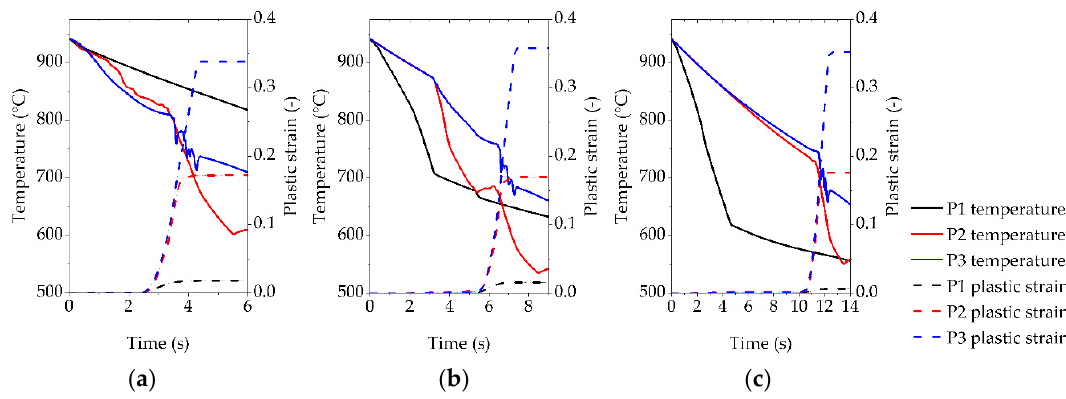
Figure 16. Temperature–plastic strain vs. time diagram for the X46Cr13 alloy during blank transfer and forming step from an initial austenitization temperature of 1050 °C for different soaking time intervals: case ( a ) immediate transfer, case ( b ) after 3 s, and case ( c ) after 8 s.